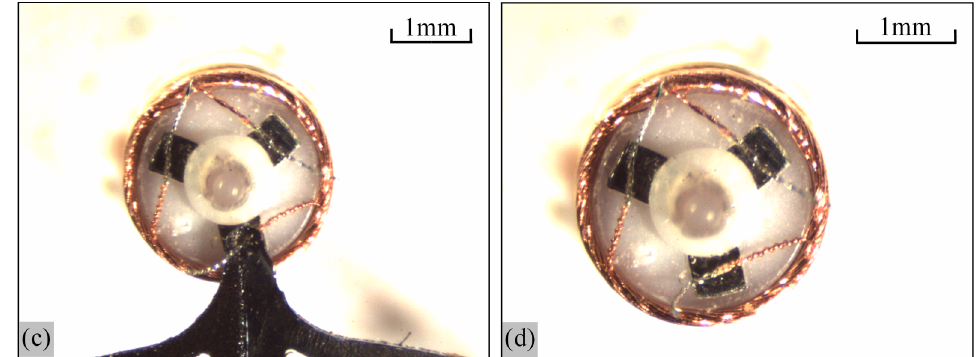
Figure 18. A process of clamping a wire with micro-gripper: ( a ) Initial positions of micro-gripper and wire; ( b ) The status that micro-gripper captures the wire; ( c ) The status that micro-gripper carries the wire over the pad; ( d ) The status that micro-gripper releases the wire.